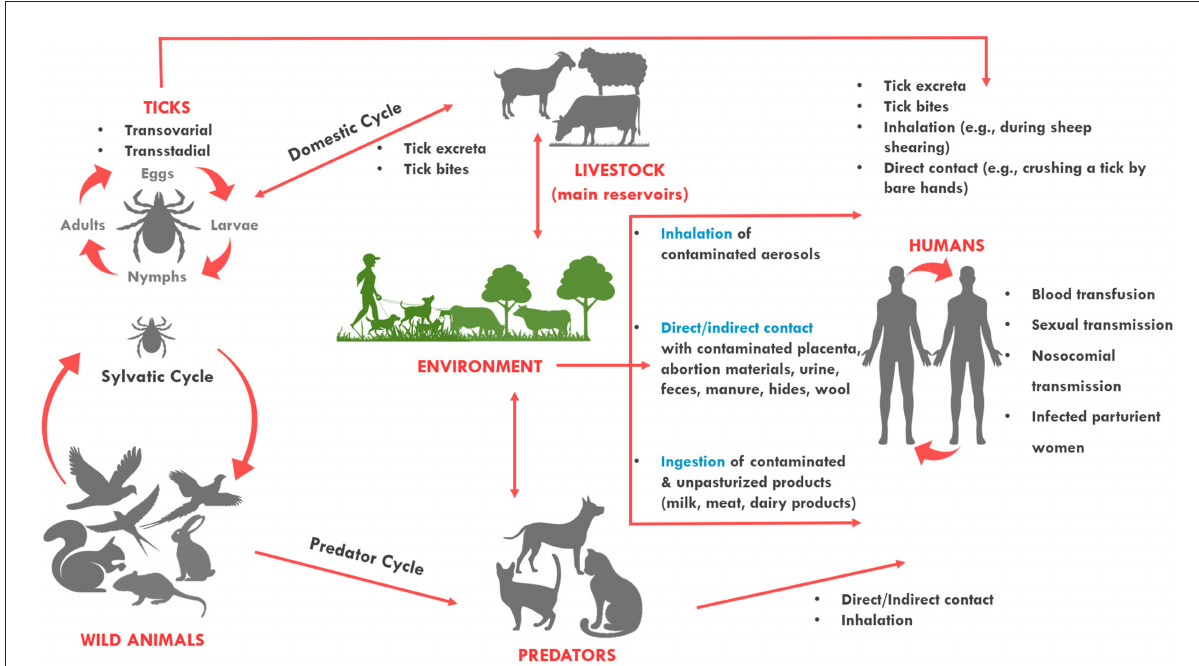
FIGURE1 Transmission routes of Coxiella burnetii . The bacterium is most often transmitted to humans during parturition of animals. It can be transmitted to humans when they directly come into contact with or inhale contaminated dust from infected animals. It can also be transmitted from a tick bite or by ingesting contaminated/unpasteurized milk and dairy products. Among humans, the bacterium can be transmitted through blood transfusion, sexual, nosocomial and vertical transmission. Sheep, cattle, and goats are the most common reservoirs of the organism for human infection, but infected cats and less commonly dogs can also transmit the infection to humans. Ticks also harbor the organism and are thought to maintain transmission to wildlife species. Dogs and cats, and humans can also become infected when they contact (or ingest) wildlife